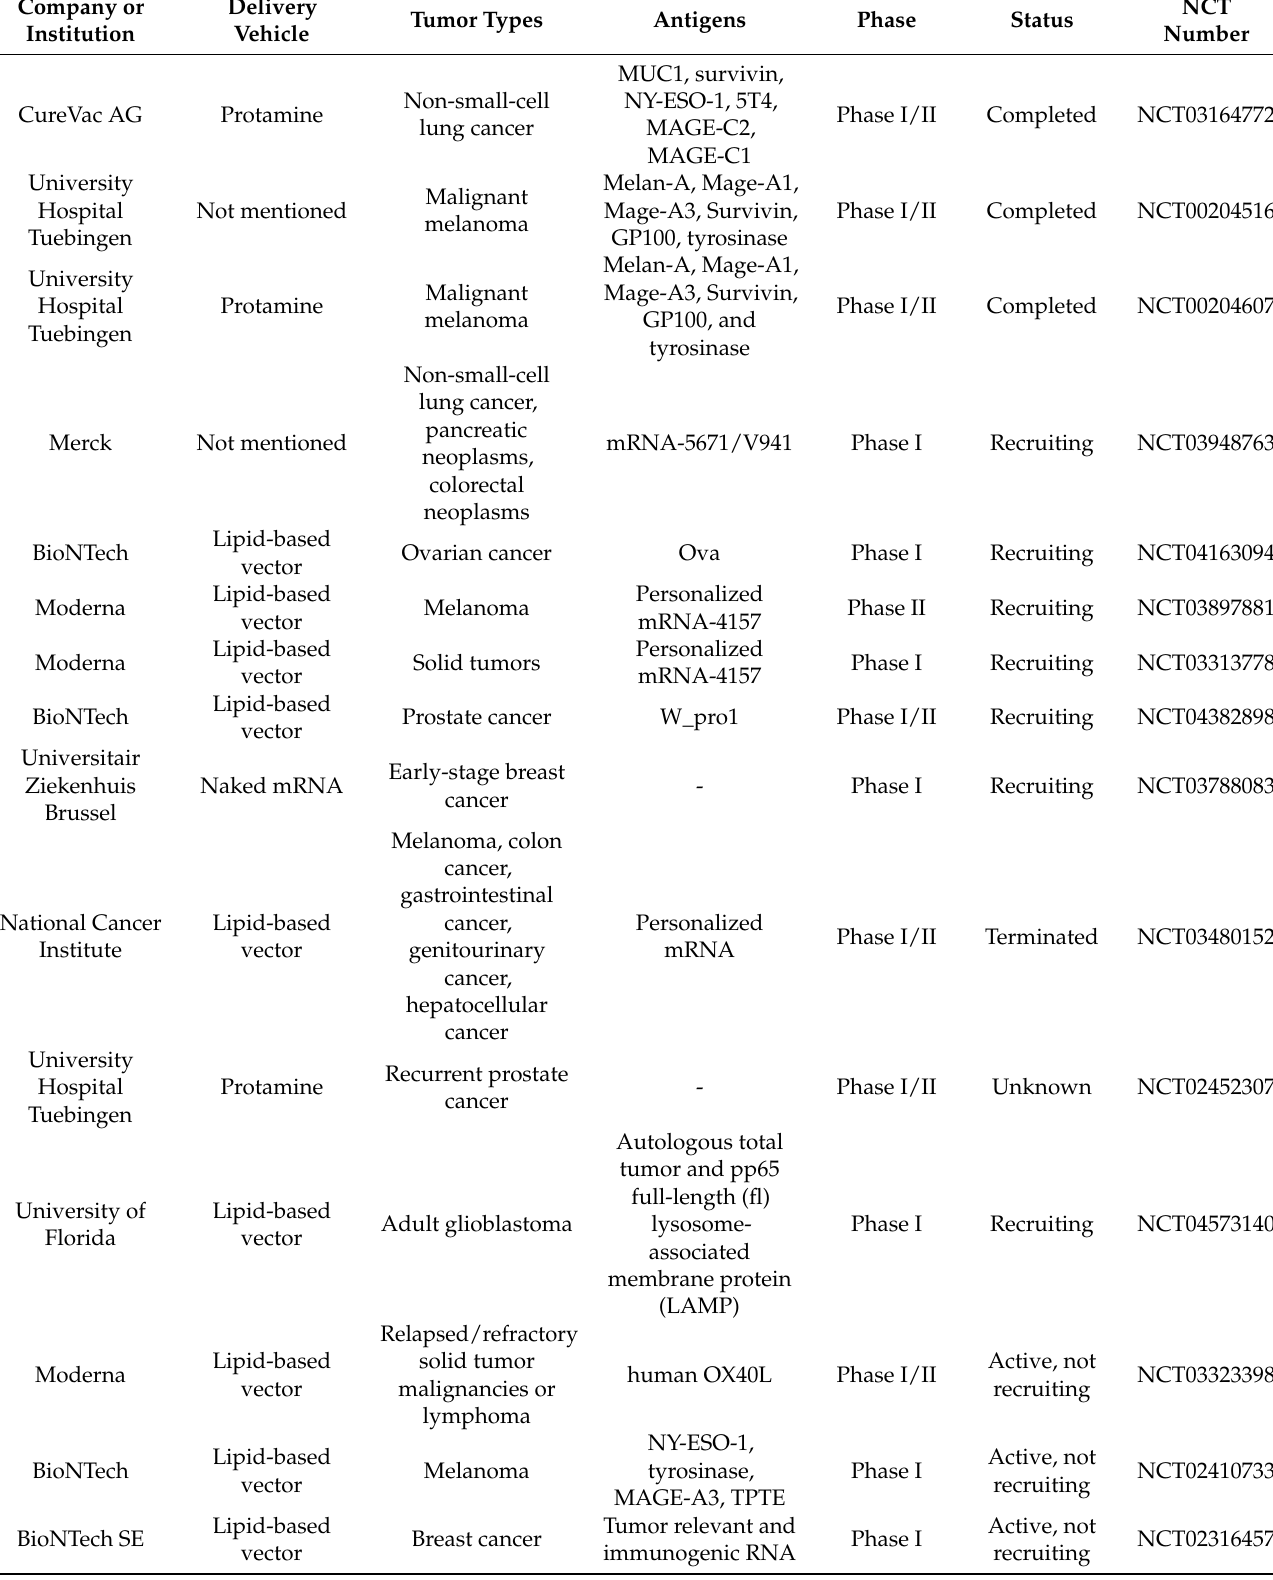
Table 4. The clinical trials of mRNA cancer vaccine based on direct